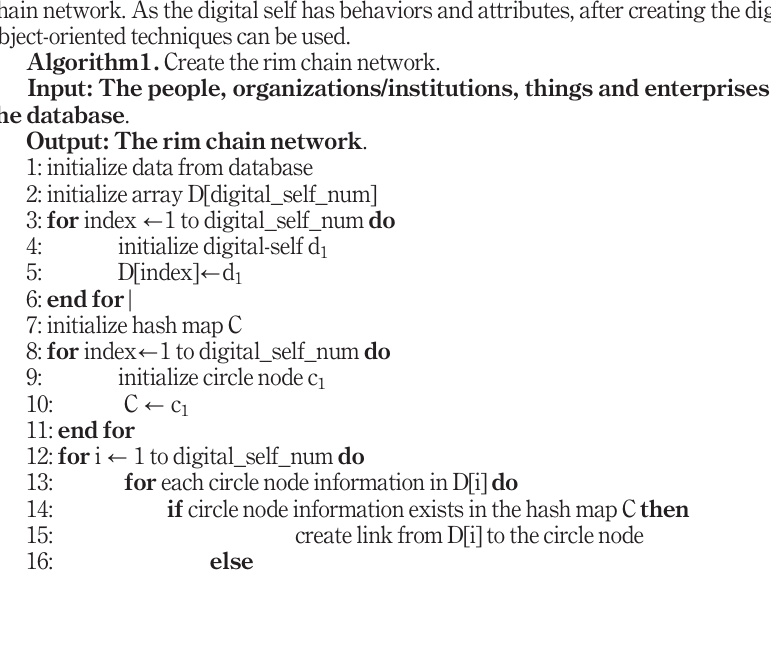
Algorithm1. Create the rim chain network.